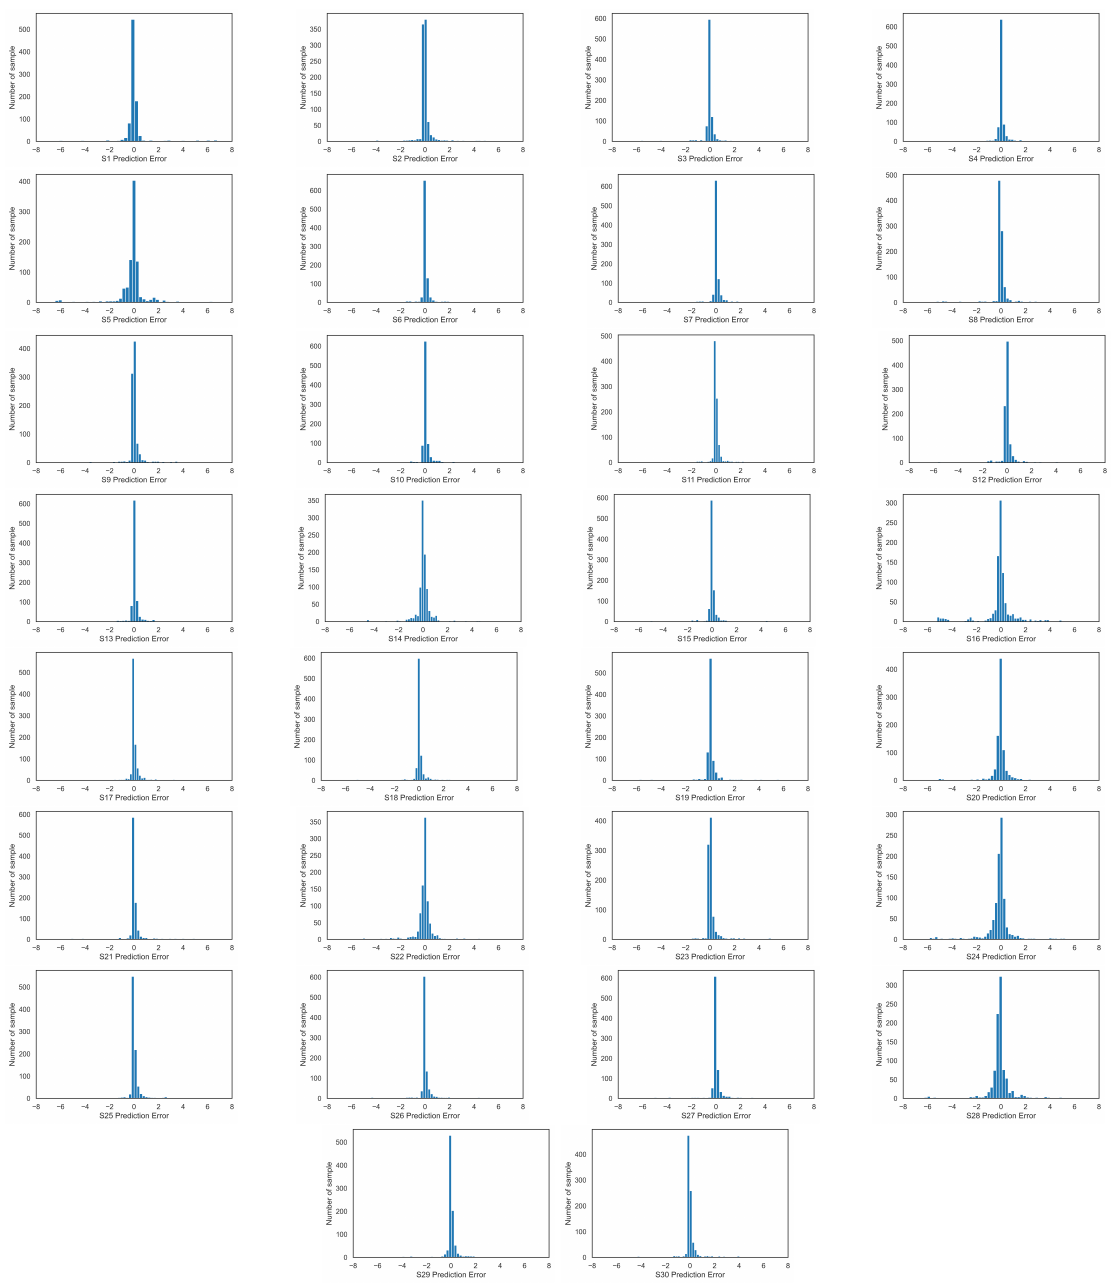
Figure 6. Histogram of prediction errors for 30